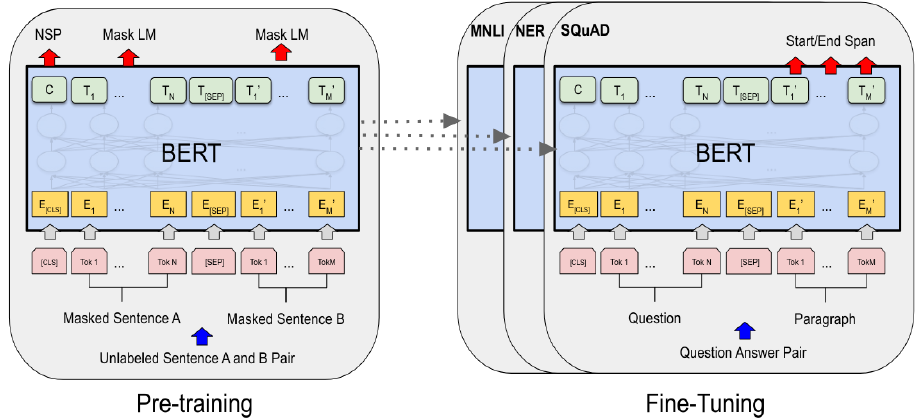
Figure 5. The general pre ‐ training and fine ‐ tuning procedures for BERT.